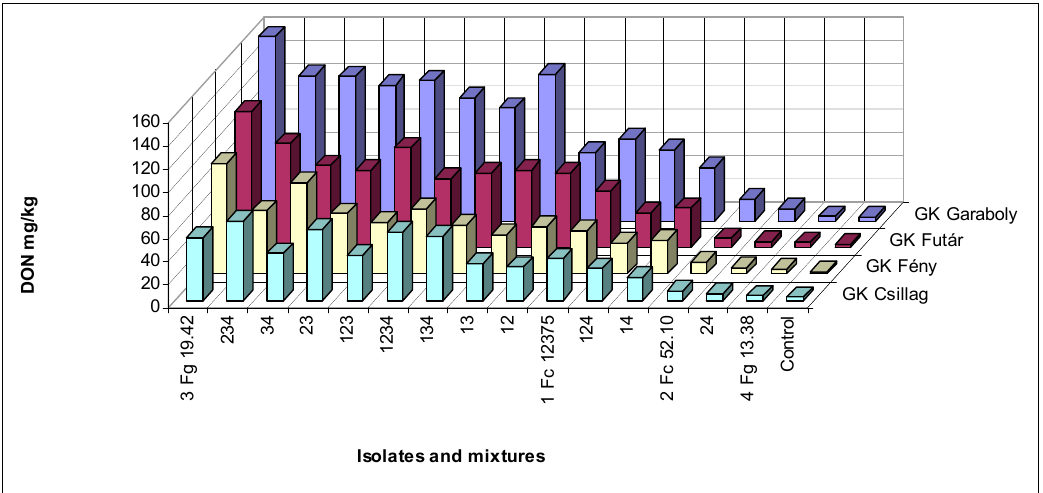
Figure 2. Influence of mixing isolates on the resistance expression of the four cultivars with differing FHB resistance. DON contamination across years and experiments. LSD 5% between any bars in the figure is 18.71.